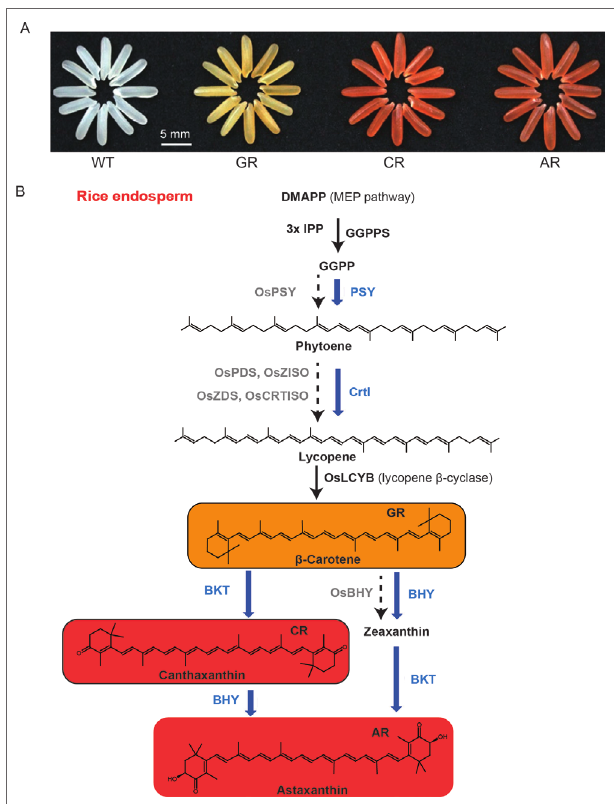
FIGURE 1 | Biofortification of nutrients in rice endosperm. (A) Grains of the wild-type (WT), the golden rice (GR), canthaxanthin rice (CR), and astaxanthin rice (AR). (B) Simplified carotenoid/canthaxanthin/astaxanthin biosynthesis pathways reconstructed in rice endosperm. The enzymes (in blue) expressed from different combinations of the transgenes, together with those (in black) from the endogenous MEP pathway genes and OsLCYB, catalyze the biosynthesis of β -carotene, canthaxanthin, and astaxanthin as the main products in the GR, CR, and AR lines, respectively. The rate-limiting enzymes of the endogenous genes with no or low levels of expression are shown in gray. The figure is modified with permission from